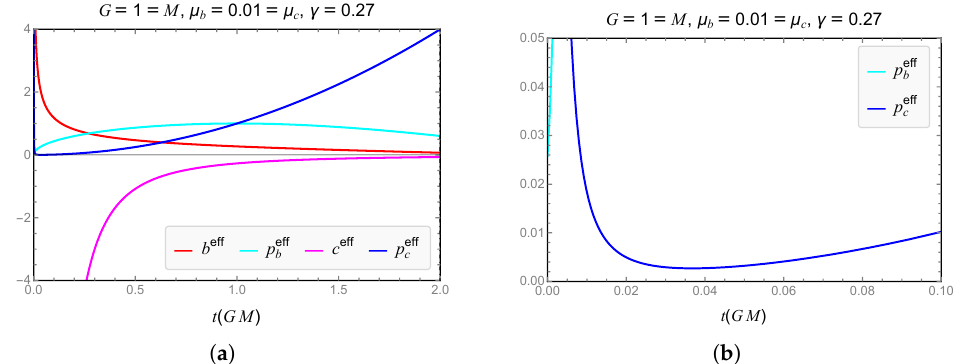
Figure 3. Solutions of the EoM of the ˚ µ case. ( a ) Solutions to the equations of motion in ˚ µ case as a function of the Schwarzschild time t . ( b ) Close up of the EoM of p c close to t = 0. We can see that p c never